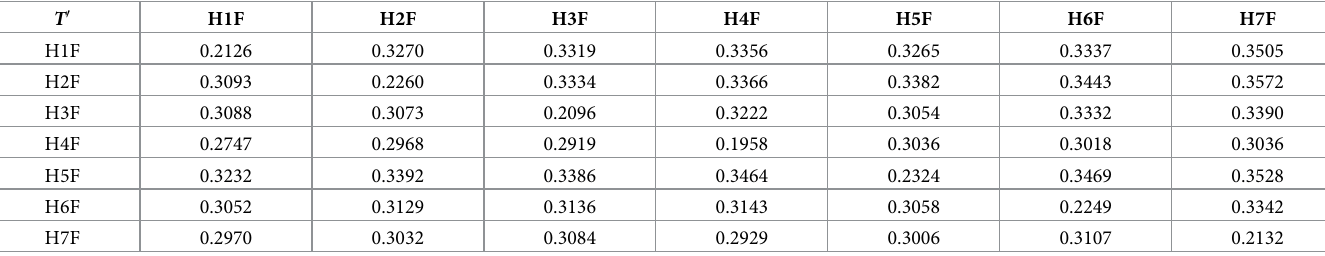
Table 6. Modify total-relation